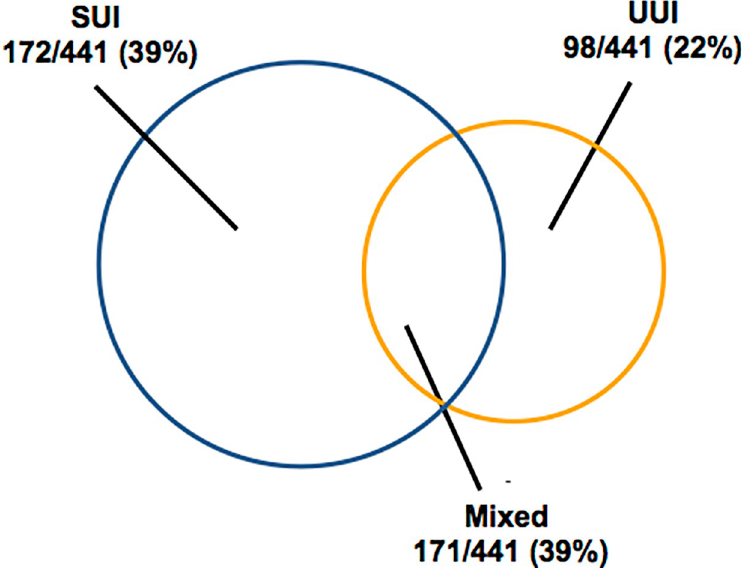
Fig 1. Proportions of stress urinary incontinence (SUI), urge urinary incontinence (UUI), and mixed urinary incontinence (MUI) among 441/1048 women reporting any urinary incontinence.